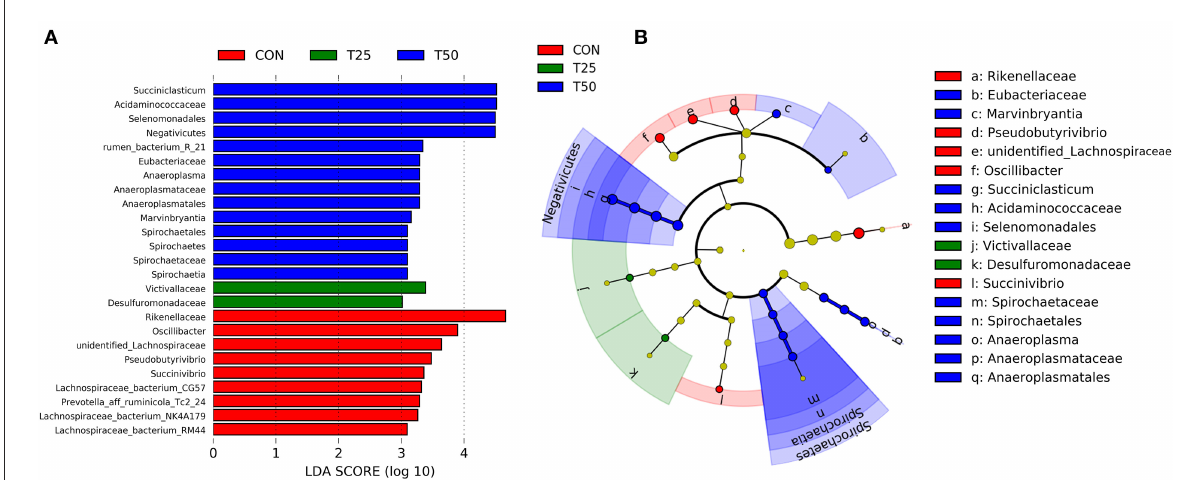
FIGURE7 LEfSe analysis of rumen microflora. (A) LDA bar chart; (B) LEfSe evolution branch diagram. The graph reflects the affiliation of flora populations between groups at the species to phyla level, with node size corresponding to the average relative abundance of the corresponding taxon.